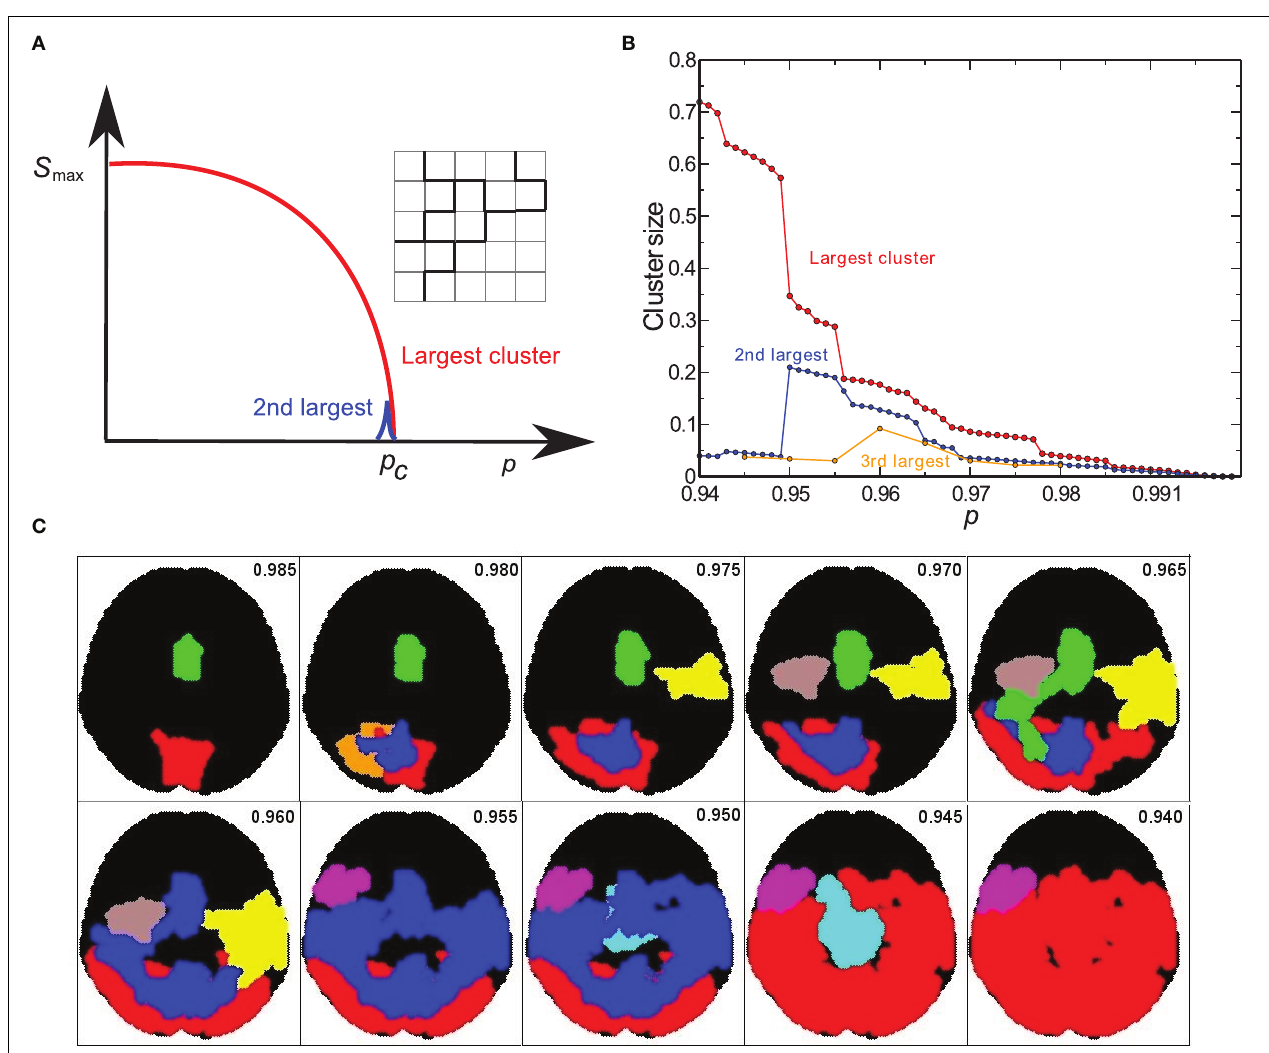
p for a given subject. As we lower p the cluster size increases in jumps, and new clusters emerge, grow, and finally get absorbed by the largest cluster. This behavior is significantly different from the random percolation in (A) . (C) Cluster evolution. Brain clusters with more than 1000 voxels, as identified through correlation analysis for a given p